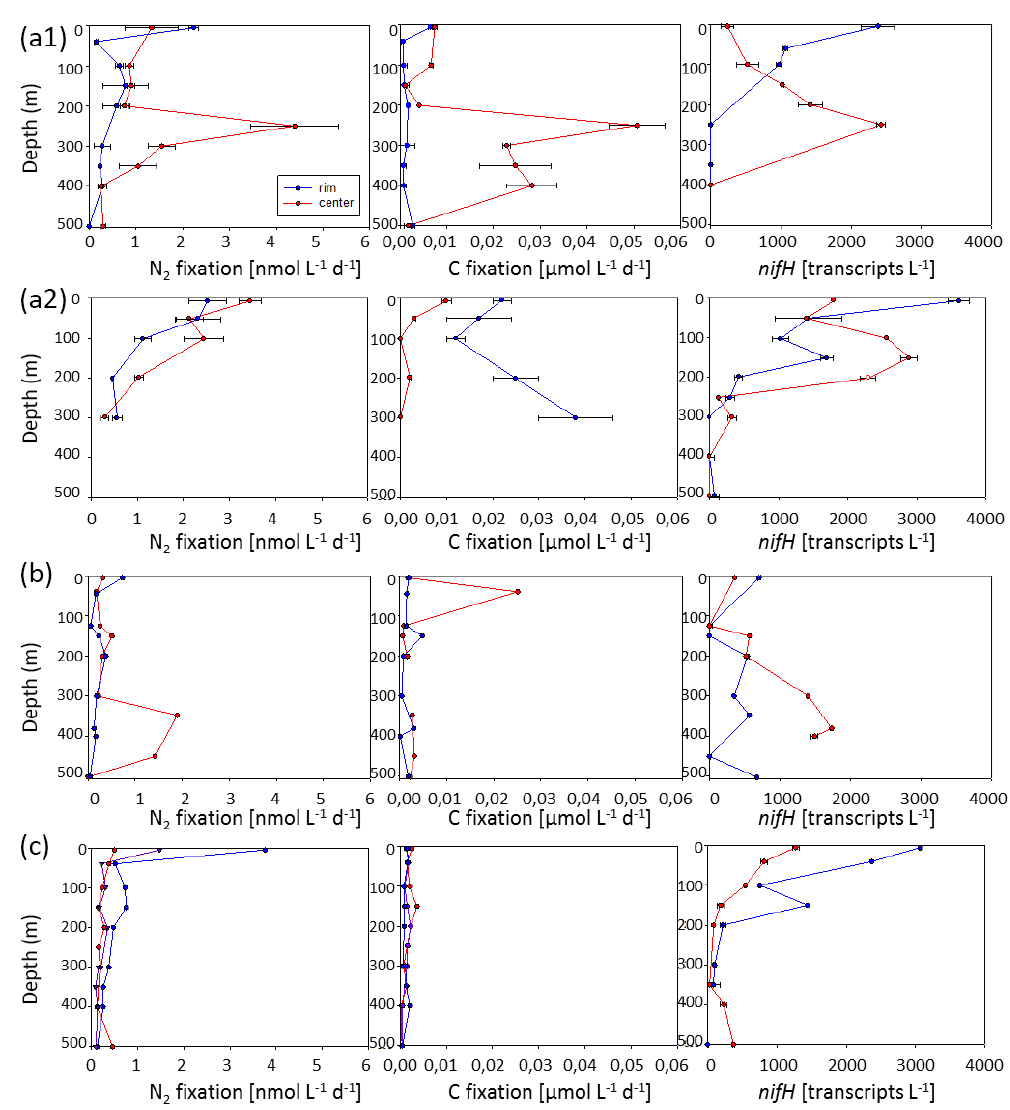
Figure 3. Vertical distributions of N 2 and C fixation rates and nifH transcript abundance (sum of detected clusters P2, P7 and Crocosphaera - like diazotrophs as quantified by qPCR) in eddy A1 (M90) ( a1 ), eddy A2 (M91) ( a2 ), eddy B ( b ) and eddy C ( c